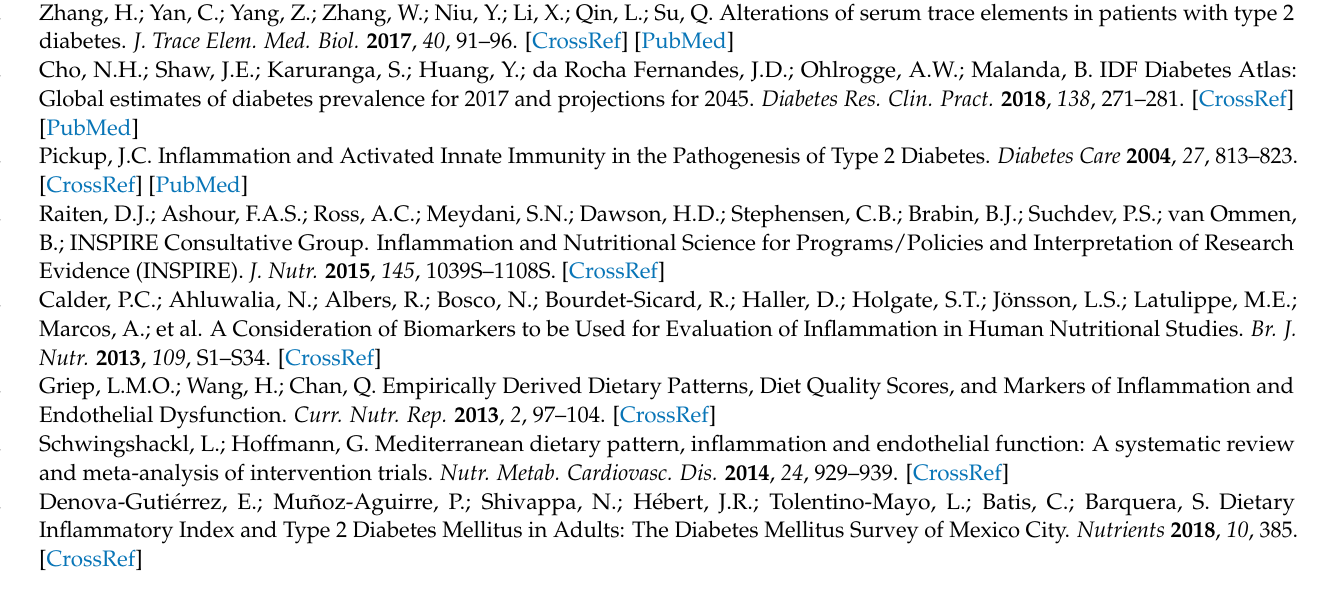
the manuscript is attached as “Supplementary Files”: Table S1: Subgroup of Control Diet, Table S2: Subgroup of type of center, Table S3: Subgroup of follow-up, Table S4: Subgroup of Control Glycemic, Table S5: Subgroup of Region, Table S6: Subgroup of Study Design, Table S7: Subgroup of Type of Diet, Table S8: Subgroup of Control and Experimental Diet, Table S9: Subgroup of Med Diet, Table S10: The “Risk of Bias” tool. Clinical Trials. * For review, Table S11: Characteristics and properties of components of Mediterranean diet styles, Figure S1: Funnel plot of comparison: final values, outcome: Adiponectin, Figure S2: Funnel plot of comparison: final values, outcome: